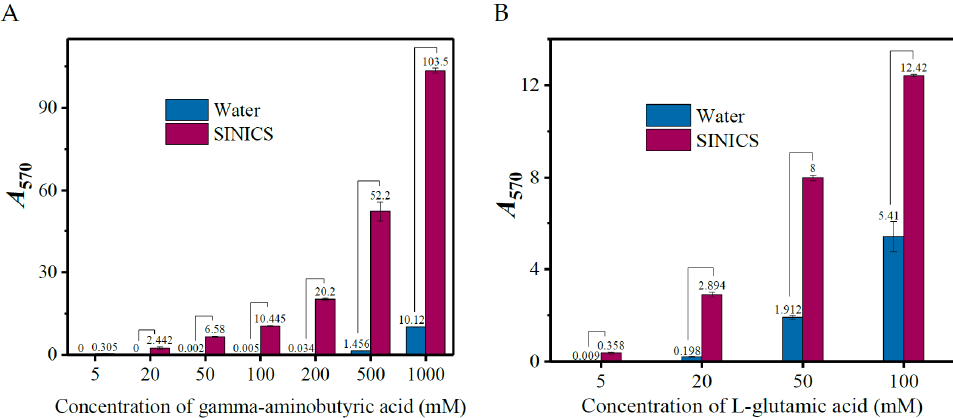
Figure 8. Chromogenic sensitivity of SIANCS to gamma-aminobutyric acid ( A ) and L-glutamic acid ( B ). The control reaction medium used water as a substitute for 40% ethanol-25% ethyl acetate. SIN- ICS: sensitivity intensified ninhydrin-based chromogenic system; and A 570 : absorbance at 570 nm.